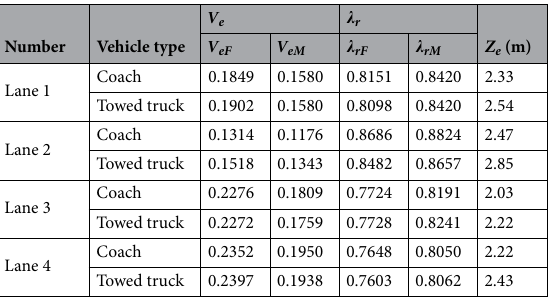
Table 4. Normalized equivalent wind speed based on fitting wind profile in lateral